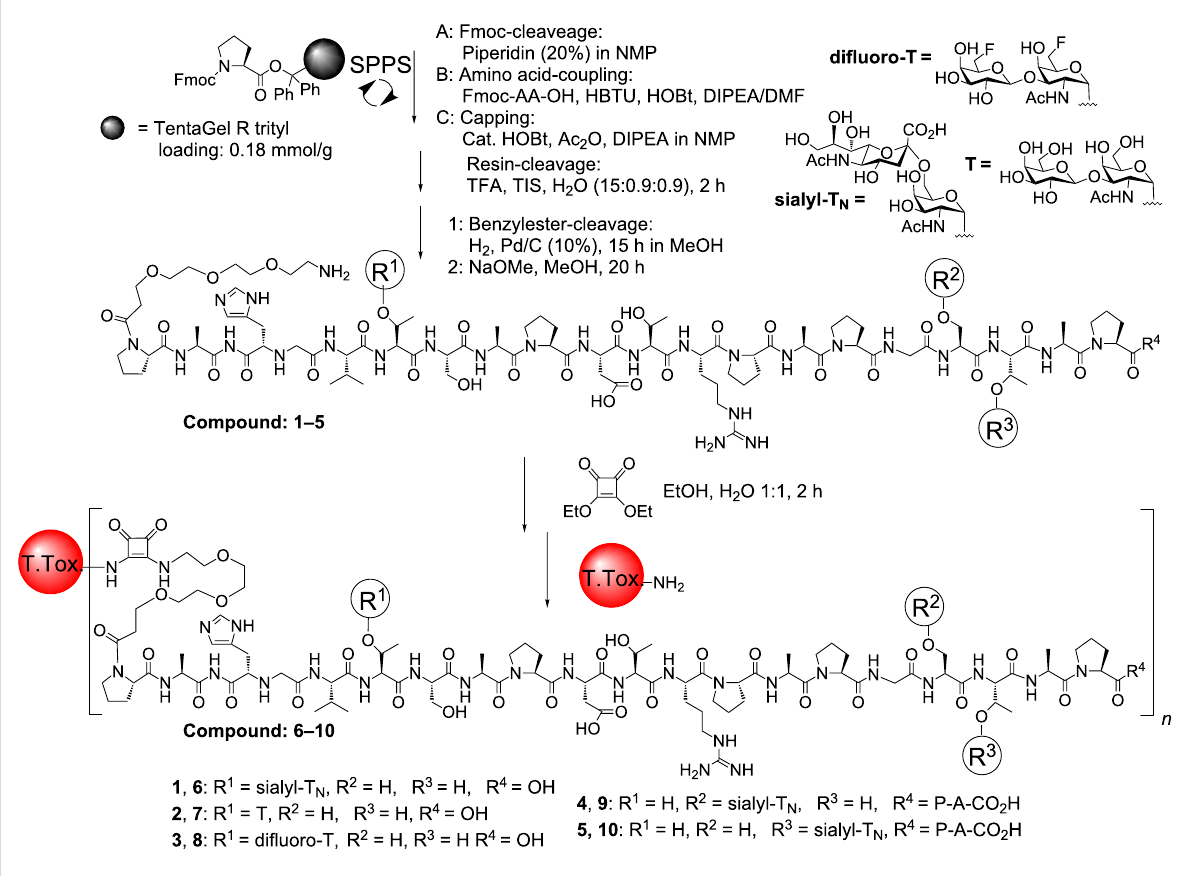
Scheme 1: Synthesis of MUC1 tetanus toxoid protein conjugate vaccines.